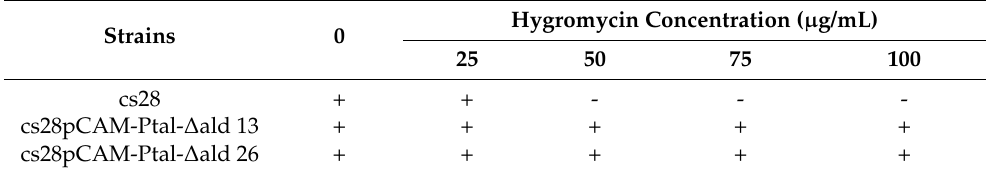
Table 3. Sensitivity of wild-type and putative mutants of F. oxysporum on hygromycin medium.